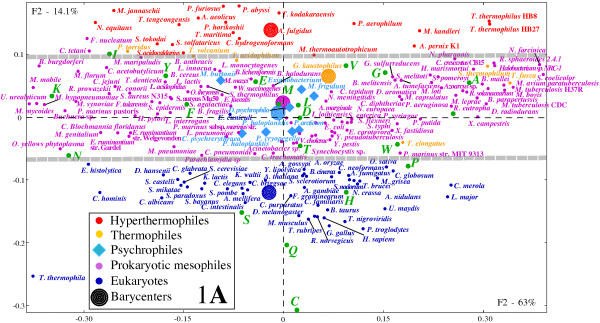
Species distribution following amino-acid compositions. Factorial plane representation, with Correspondence analysis, for the distribution of species following amino acid compositions. Species names are reported whenever possible (for full list see Additional file 1). Amino acids (one letter) are represented in green. Coding colours for hyperthemophiles, thermophiles, prokaryotic mesophiles, psychrophiles and eukaryotes are following legend in Figure 1A. Three main groups, corresponding to hyperthermophiles-thermophiles; prokaryotic mesophiles-psychrophiles and eukaryotes are roughly delimited by horizontal dashed grey lines. A: Legend for colour coding symbols. Species and barycenters symbols for the various groups that are reported in Figures 1, 2, 3 and 4 with the same colour coding conventions.